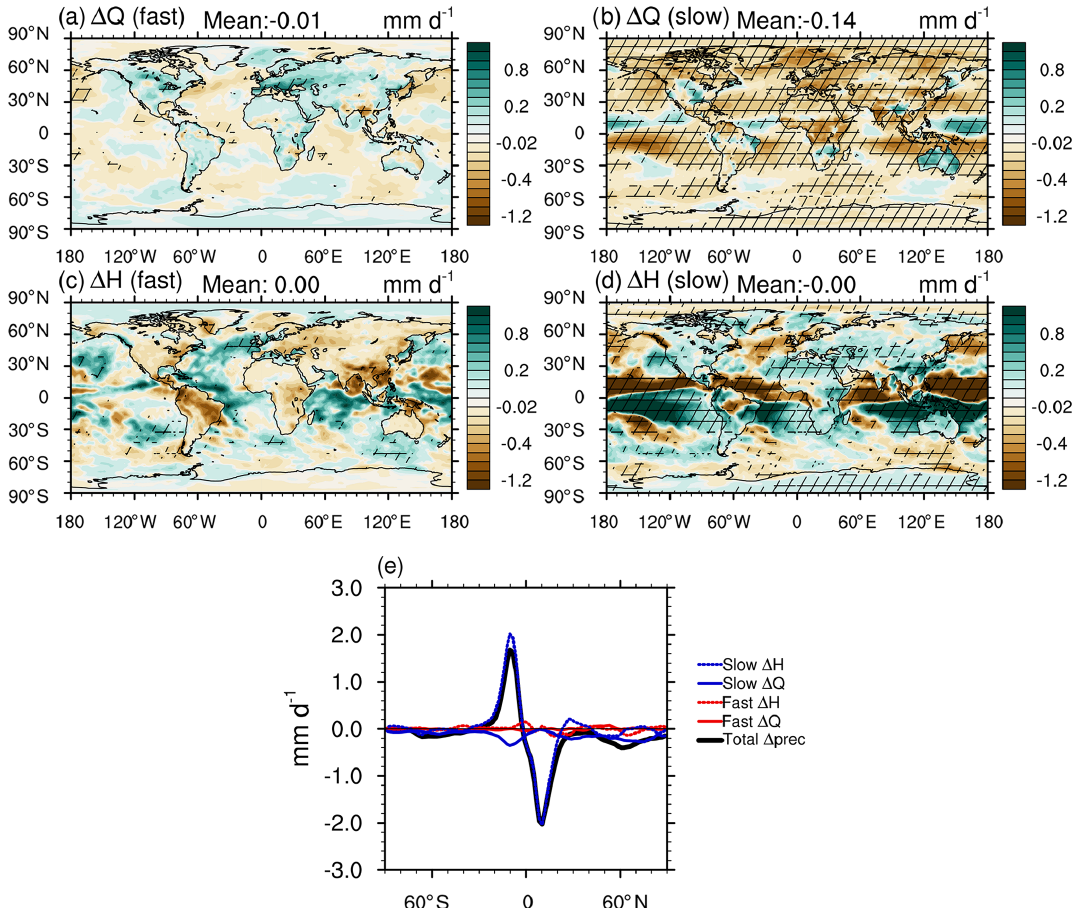
Figure 4. ECHAM6–HAM2 simulated geographical patterns of multi-annual mean changes in (a, b) atmospheric diabatic cooling and (c, d) dry static energy flux divergence for (a, c) fast responses and (b, d) slow responses to 5-fold increased SUL emission. Hatching indicates where the changes are significant (90% confidence interval through bootstrapping methods). (e) The zonal mean of total precipitation response and its decompositions, including fast and slow responses of diabatic cooling and dry static energy flux divergence. All of them are shown in equivalent precipitation units of mmd − 1